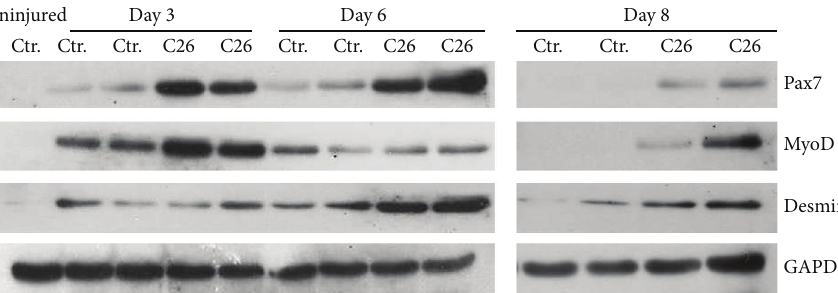
Figure 3: Early regenerative marker expression pattern in injured muscles. Representative WB images for Pax7, MyoD, and Desmin at 3, 6, and 8 days after freeze-injury. Blots were performed in duplicate for both control and C26-bearing mice. The first lane was loaded with the extract from a healthy, uninjured control muscle. GAPDH was used as loading